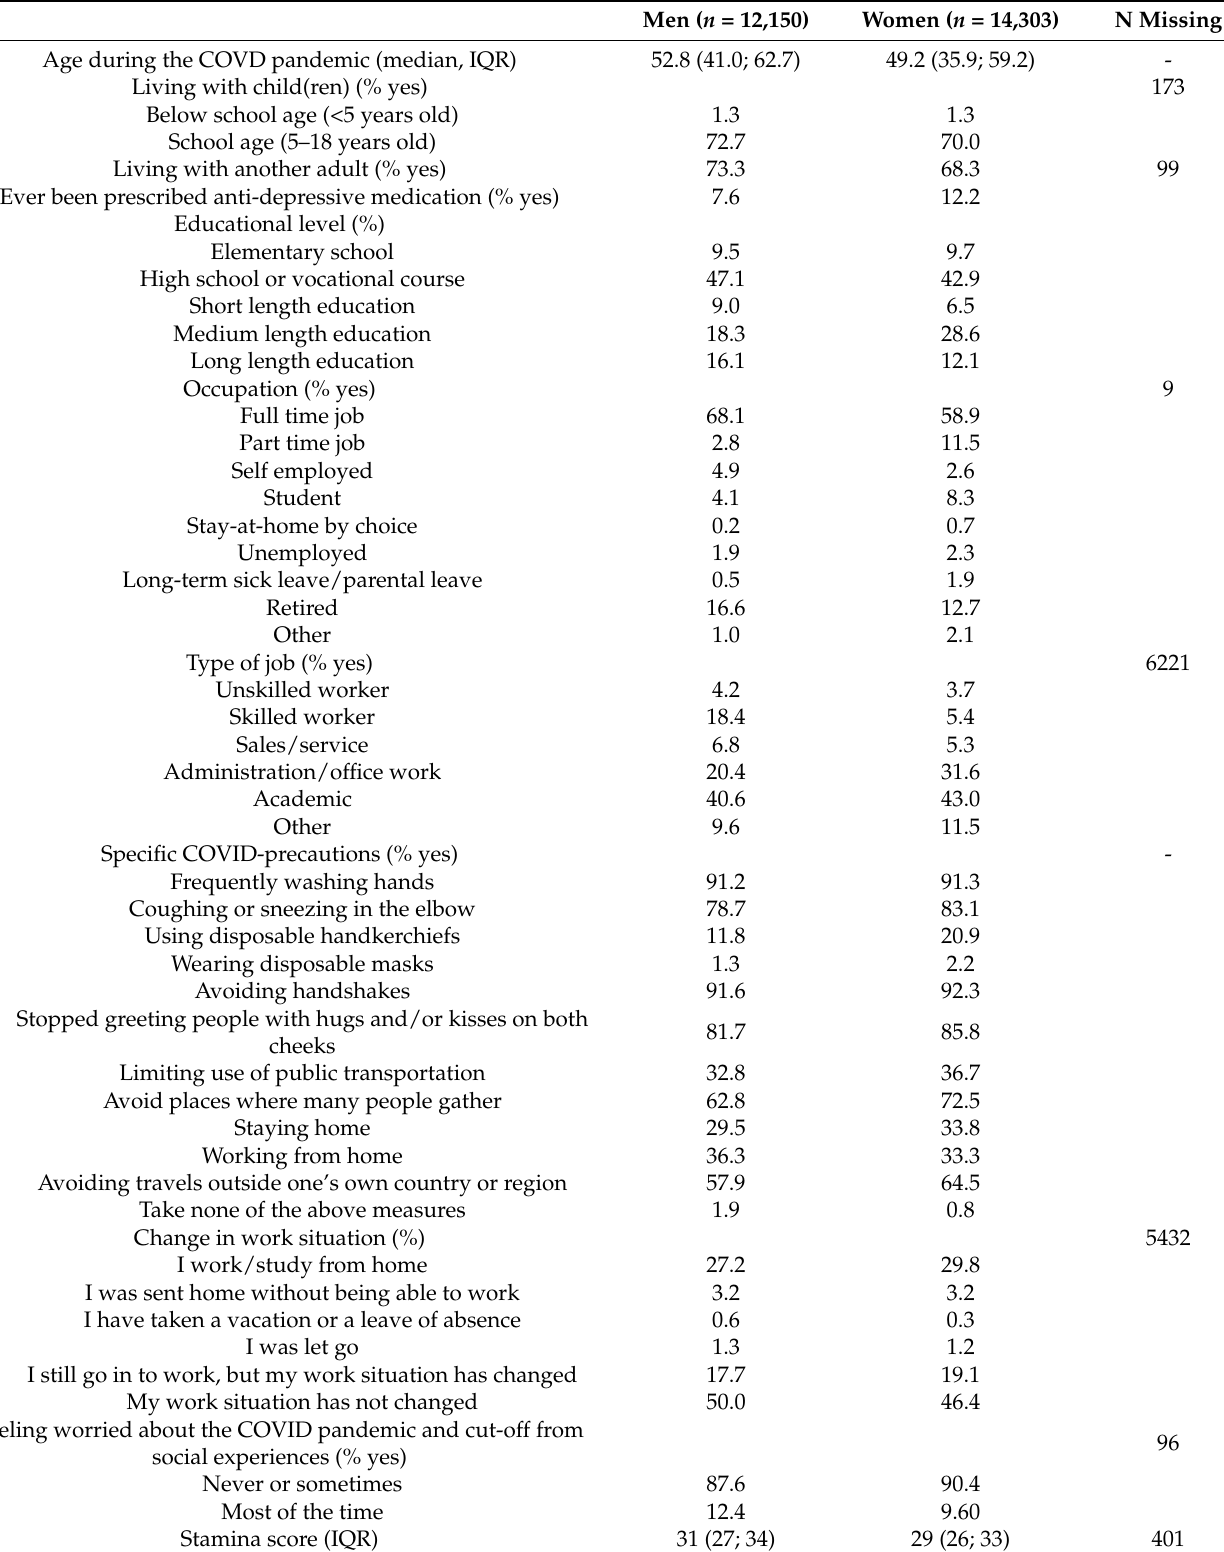
Table 1. Distribution of characteristics potentially impacting change in health during the COVID-19 pandemic. Men ( n = 12,150) Women ( n = 14,303) N Missing Age during the COVD pandemic (median, IQR) 52.8 (41.0; 62.7) 49.2 (35.9; 59.2) Living with child(ren) (%